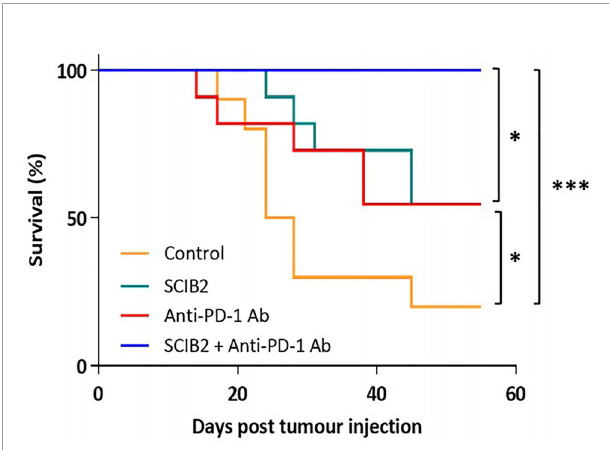
FIGURE 4 | Survival of HHDII mice challenged with 5 x10 4 tumor cells and immunized with SCIB2 and anti-PD-1 antibody alone or in combination. Control vs SCIB2 (*p = 0.037); Control vs anti-PD-1 antibody (p = 0.111); Control vs SCIB2 and anti-PD-1 antibody (***p = 0.0003); SCIB2 vs SCIB2 and anti-PD-1 (* = 0.0177); anti-PD-1 antibody vs SCIB2 and anti-PD-1 (*P = 0.0177). Lack of survival was de fi ned as tumor size > 528 mm 3 . Each curve represents at least 10 mice per